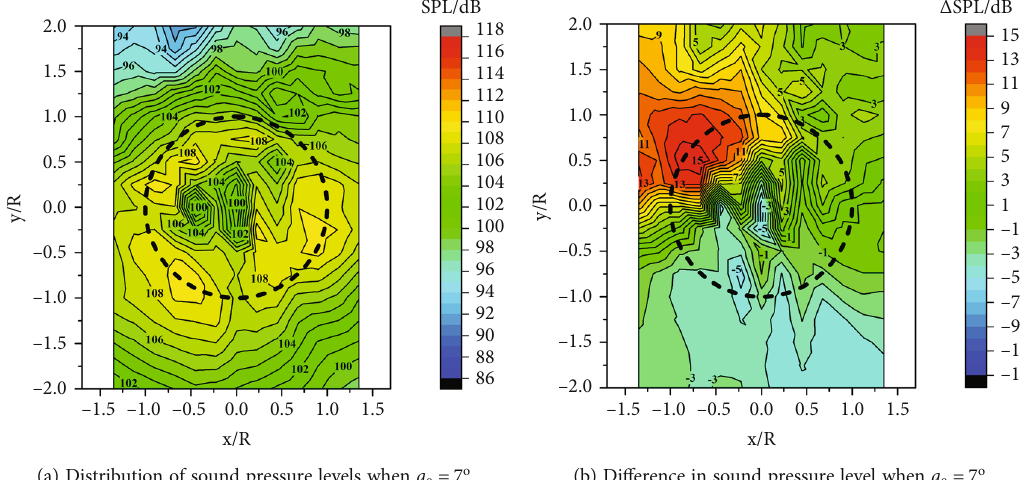
Figure 18: Distribution of SPL below the ECR under Scheme D and their di ff erence from the sound level in the reference